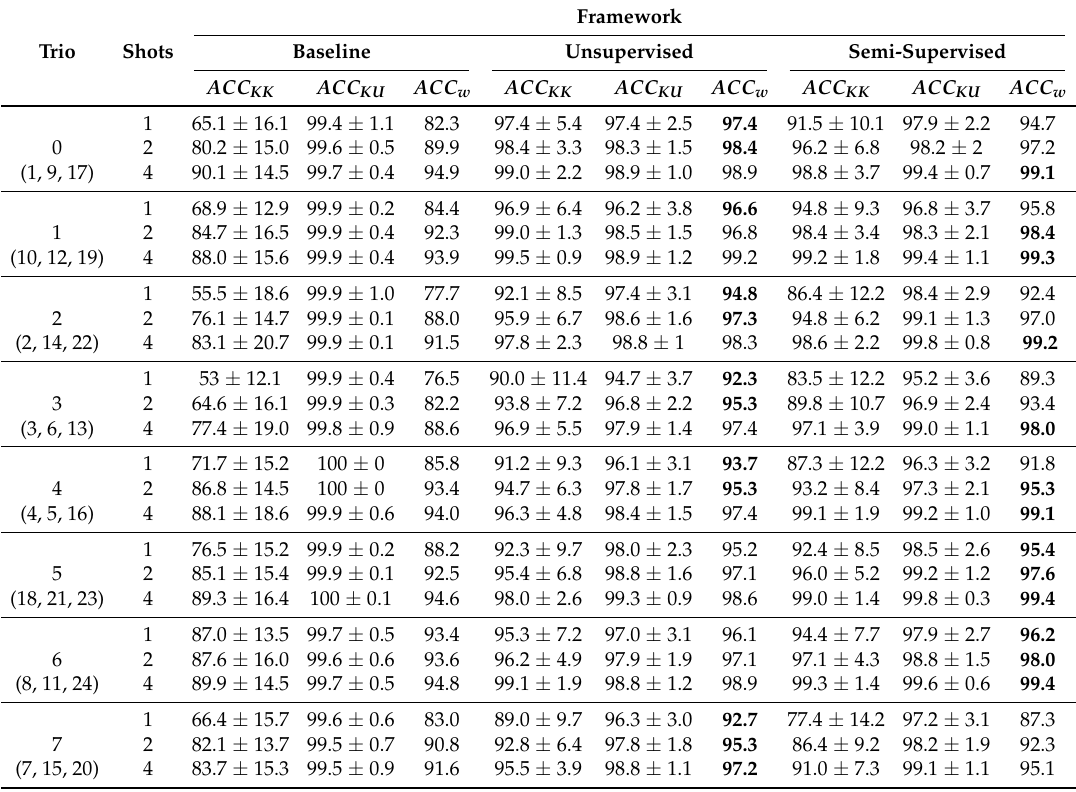
Table 4. Results with trios configuration and O ∗ = 0. The number list under the trio number corresponds to the number of patterns that make up that trio. The bold numbers indicate winning configurations according to the number of